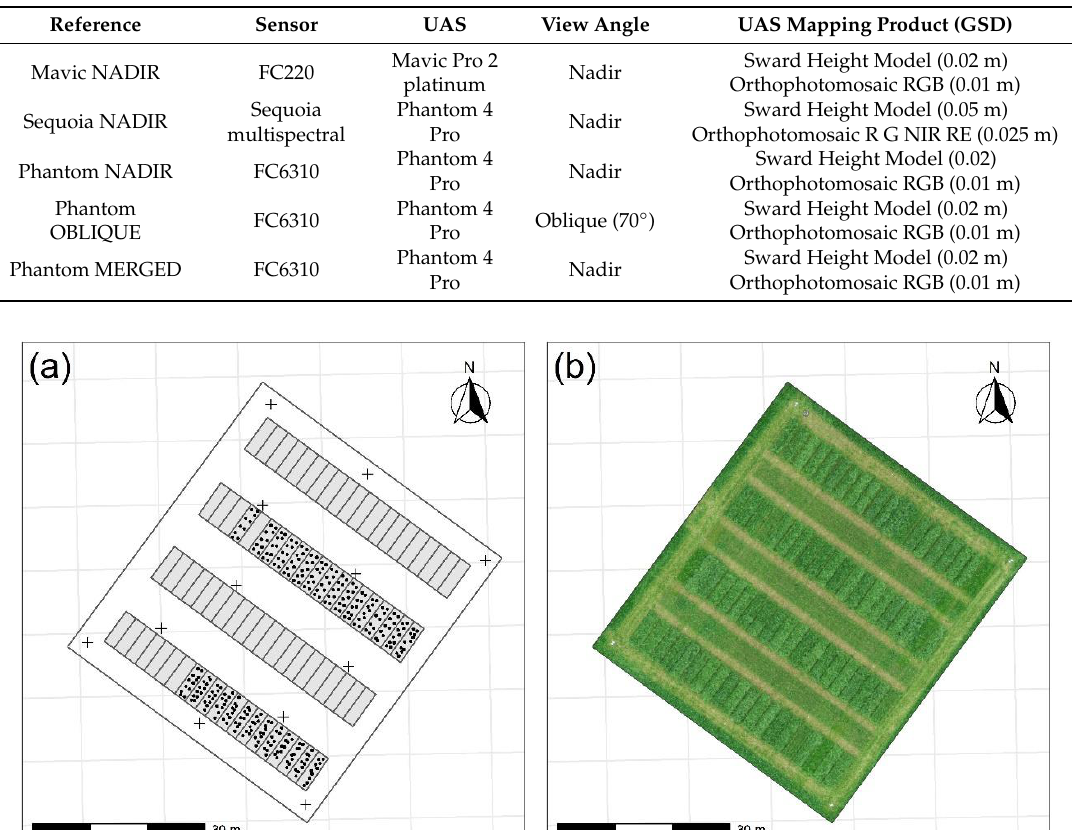
Table 1. The unmanned aerial system (UAS) survey strategies evaluated. For each reference, the associated mapping products describe the raster data used to predict pasture parameters. R: red; G: green; B: blue; NIR: near-infrared; RE: red-edge; GSD: ground sampling distance.